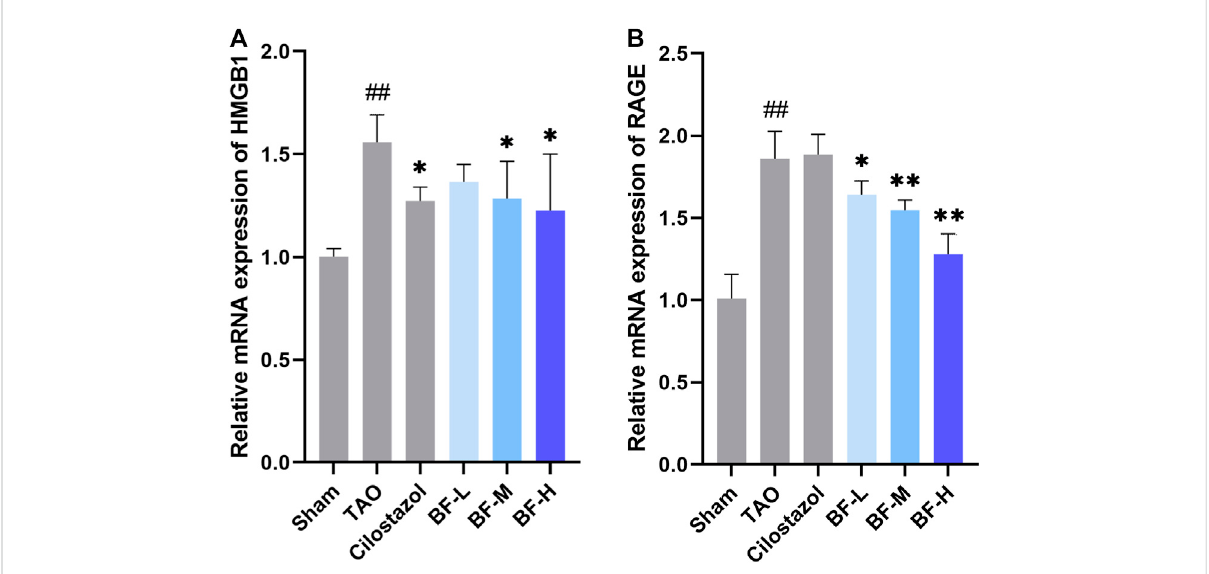
FIGURE 7 Impact of Baiying Qingmai Formulation (BF) on the mRNA levels of (A) HMGB1 and (B) RAGE in the femoral artery of rats with TAO. Data are presented as mean ± SEM ( n = 3). # p < 0.05, ## p < 0.01 versus Sham, * p < 0.05, ** p < 0.01 versus TAO. Sham: sham-operated group; TAO: TAO model group; Cilostazol: cilostazol group; BF-L: BF low-dose group; BF-M: BF medium-dose group; BF-H: BF high-dose